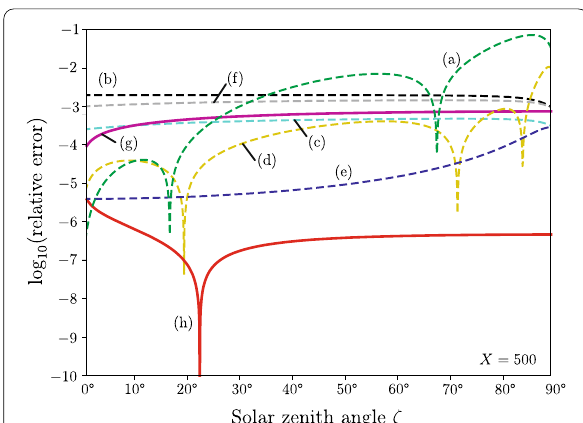
Fig. 2 Accuracy of analytical approximations of the Chapman function as a function of solar zenith angle ζ for scale parameter X 500 . The dashed lines show the formulas found in the literature = and solid lines correspond to approximations introduced in the present article: a Green & Barnum approximation (Green and Barnum 1963), b Fitzmaurice approximation (Fitzmaurice 1964), c Swider approximation (Swider 1964), d Titheridge empirical formula (Titheridge 1988), e Kocifaj formula (Kocifaj 1996), f Huestis asymptotics, 1 term (Huestis 2001), g present work, Eq. (35), h present work, Eq.